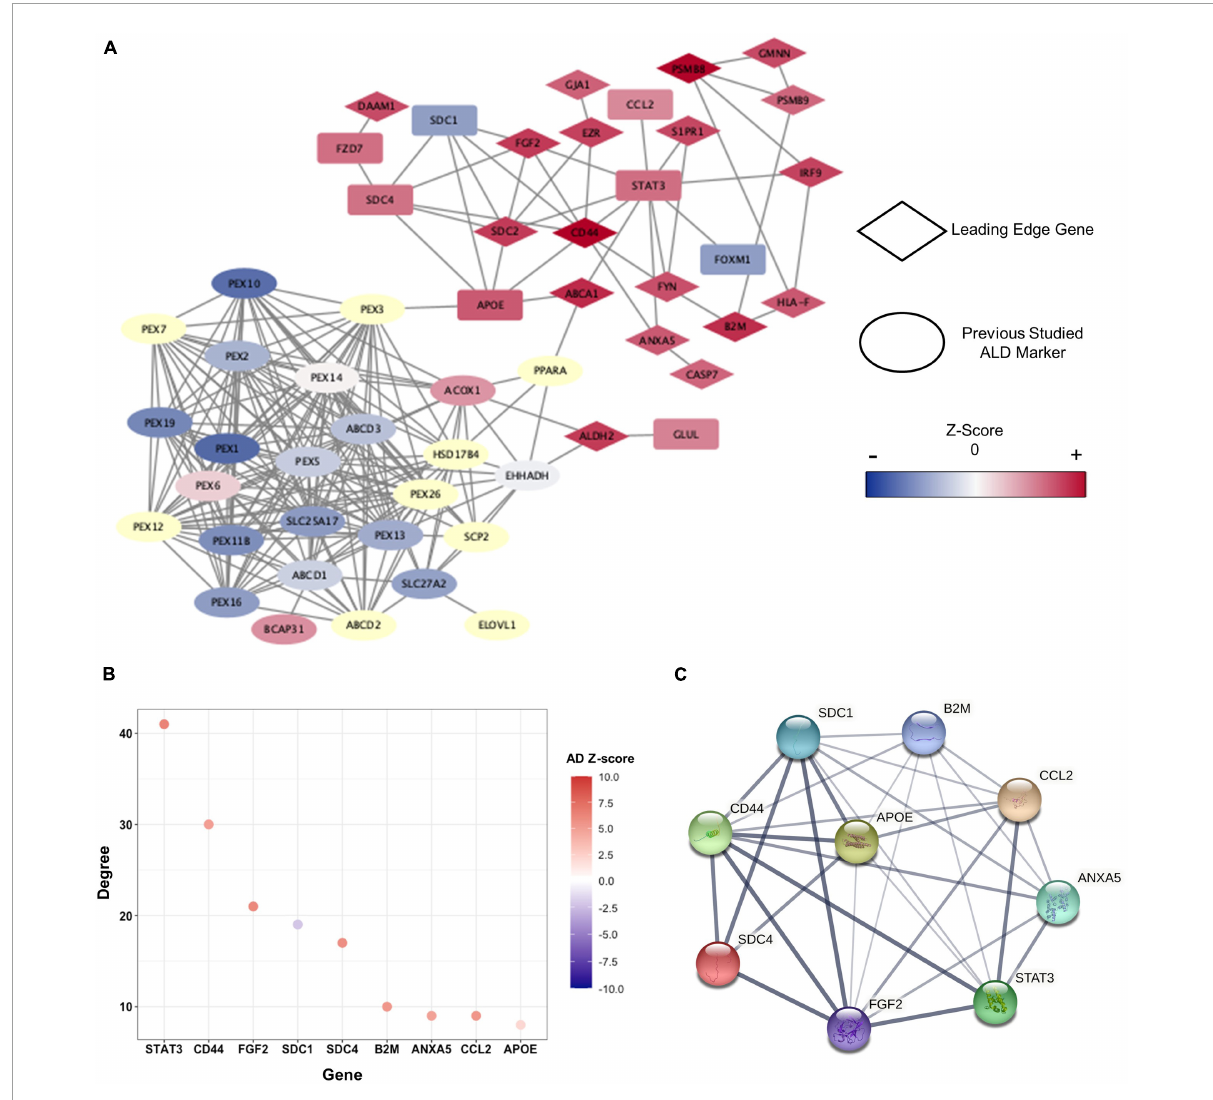
FIGURE5 Clusters within the PPI network and characteristics of hub-genes. (A) PPI network presented by cALD-related genes and genes of | Z -score| > 2 in cALD and AD among green and orange modules. The leading-edge genes are indicated by rhombi, and previously studied cALD marker genes are indicated by ellipses. The range of Z -score values in the cALD dataset of the nodes is represented by a color bar at the right. The undetected genes in the microarray are shown as pale-yellow nodes and were not used in meta-analysis. (B) The degree of hub-genes was obtained using green and orange modules. The degree of each node represents the total number of connections to other nodes in a network, and the colors of dots represent Z -scores of AD. (C) Protein interaction among hub-genes clustered around APOE. The thickness of the connected lines represents the strength of correlation between two